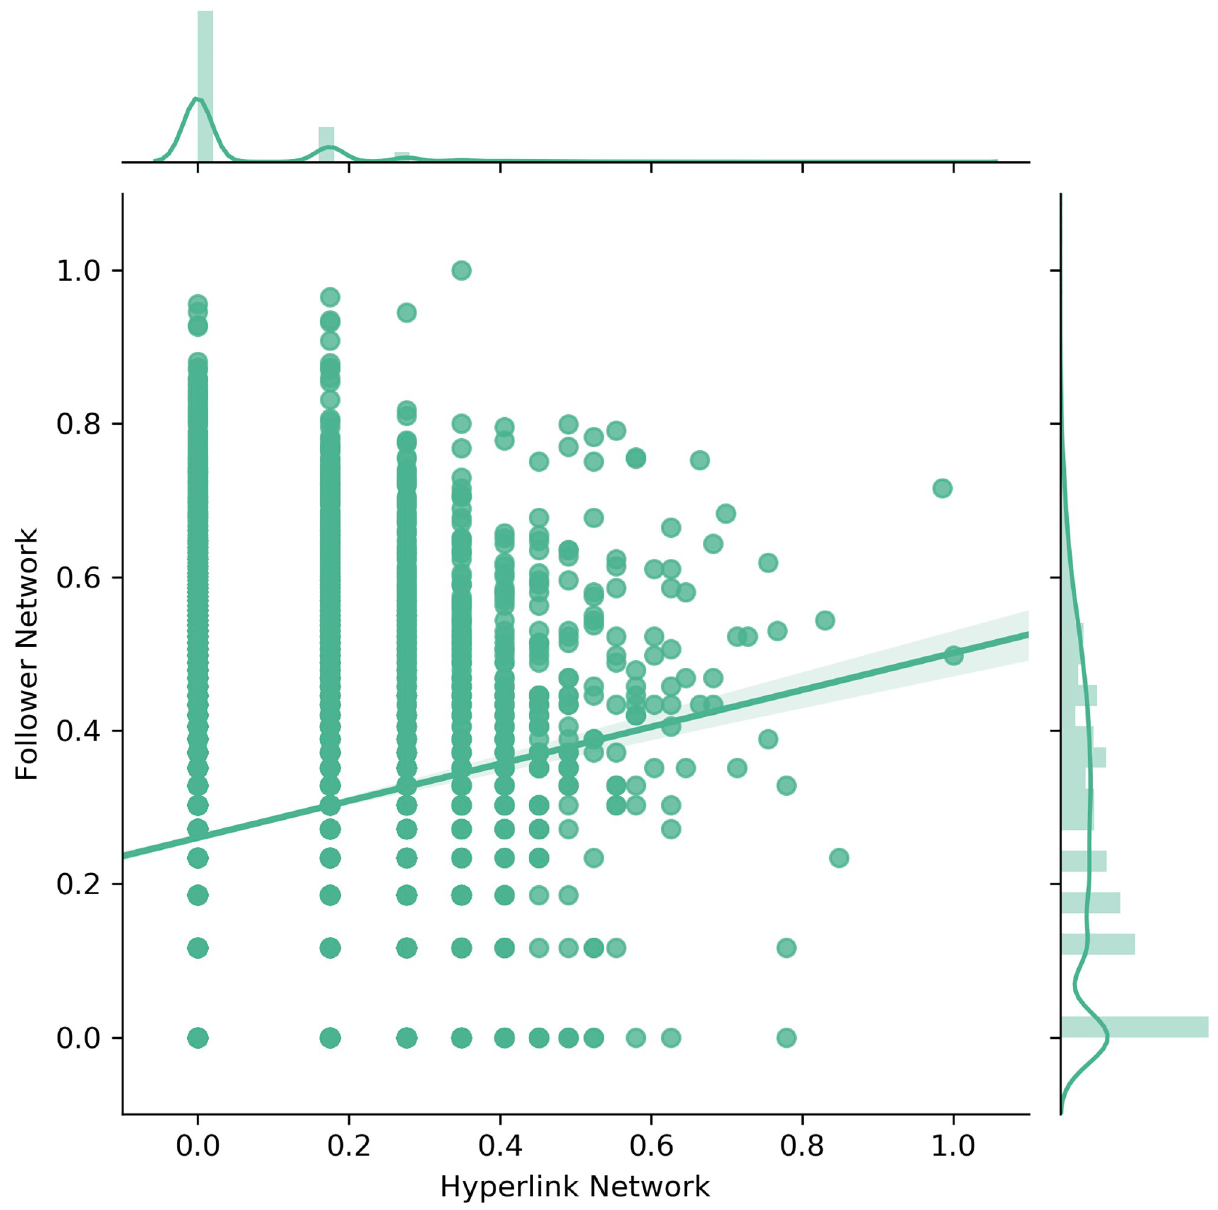
Fig 4. Scatter and density plots for degree